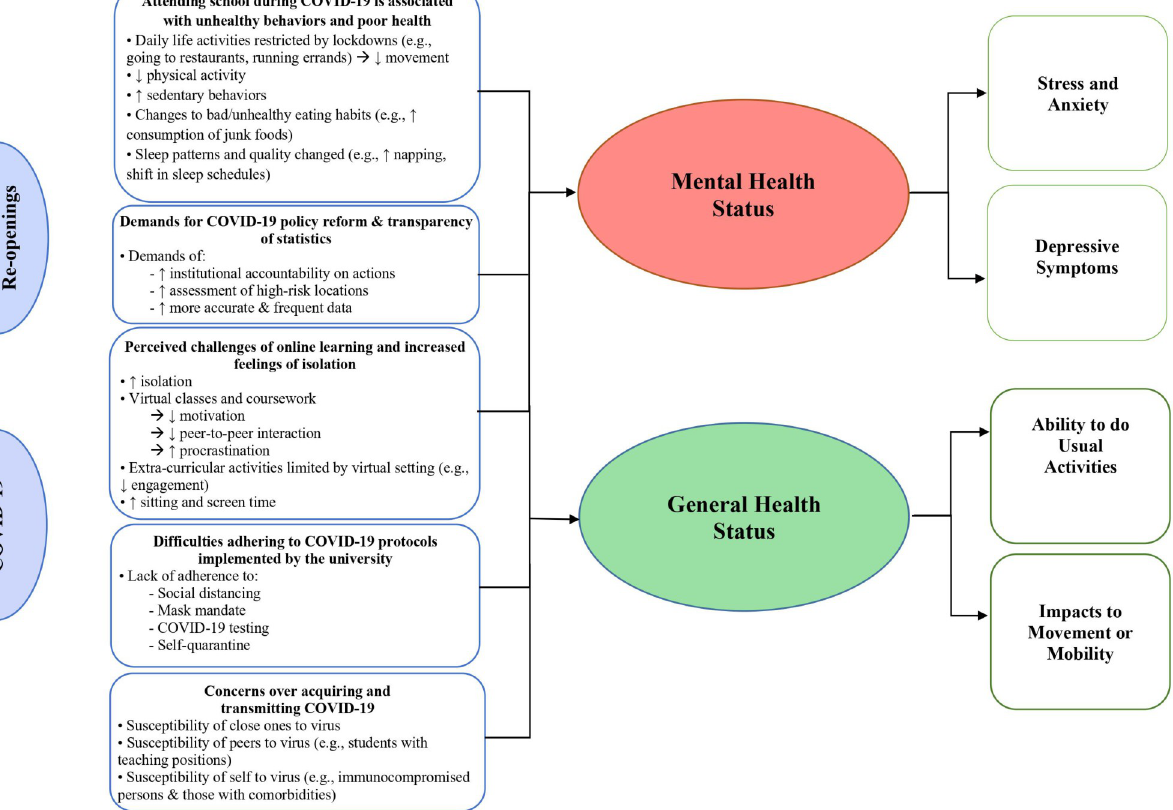
PLOS ONE | https://doi.org/10.1371/journal.pone.0279813 January 3,